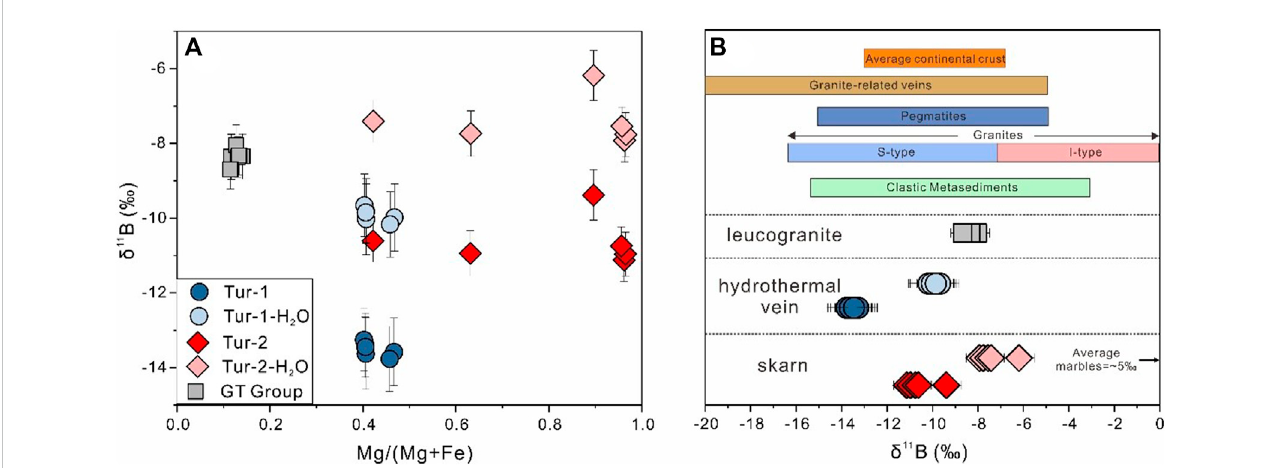
FIGURE 8 BoronisotopevariationsofTur-1andTur-2. (A) δ 11 BvaluesvsMg/(Mg+Fe)values. (B) MeasuredBisotopeandcalculatedhydrothermal fl uidcompositionsof Tur-1andTur-2comparedwithinferredBsources.ThetourmalinecompositiondataonleucograniteintheXianglinarea(GTgroup,graysquare)areobtained fromXieetal.(2022).MeasuredvaluesofBisotopecompositionsinTur-1andTur-2areindicatedbythebluecircleandredrhombus,respectively.Thecalculated hydrothermal fl uidsofTur-1andTur-2areindicatedbythelightbluecircleandlightredrhombus,respectively.Tocomparethecompositionofthesource area,thecompositionrangeoftourmalineboronisotopesinvariousrocksandcontinentalcrustaroundtheworldisalsomarked,andthedataarecollectedfrom Jiang and Palmer (1998), Xavier et al. (2008), Marschall and Jiang (2011), Trumbull and Slack (2018), and Zhou et al. (2019).